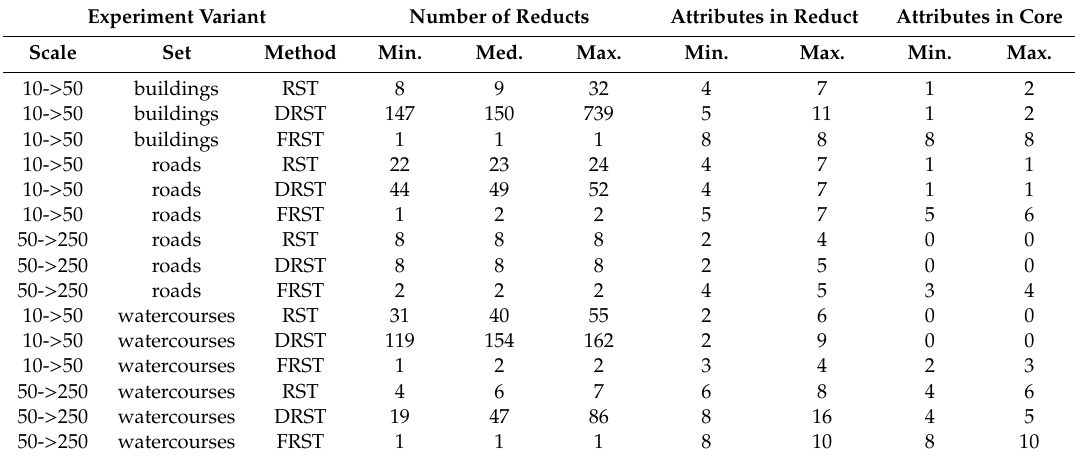
Table 16. The summary of results in di ff erent variants of the